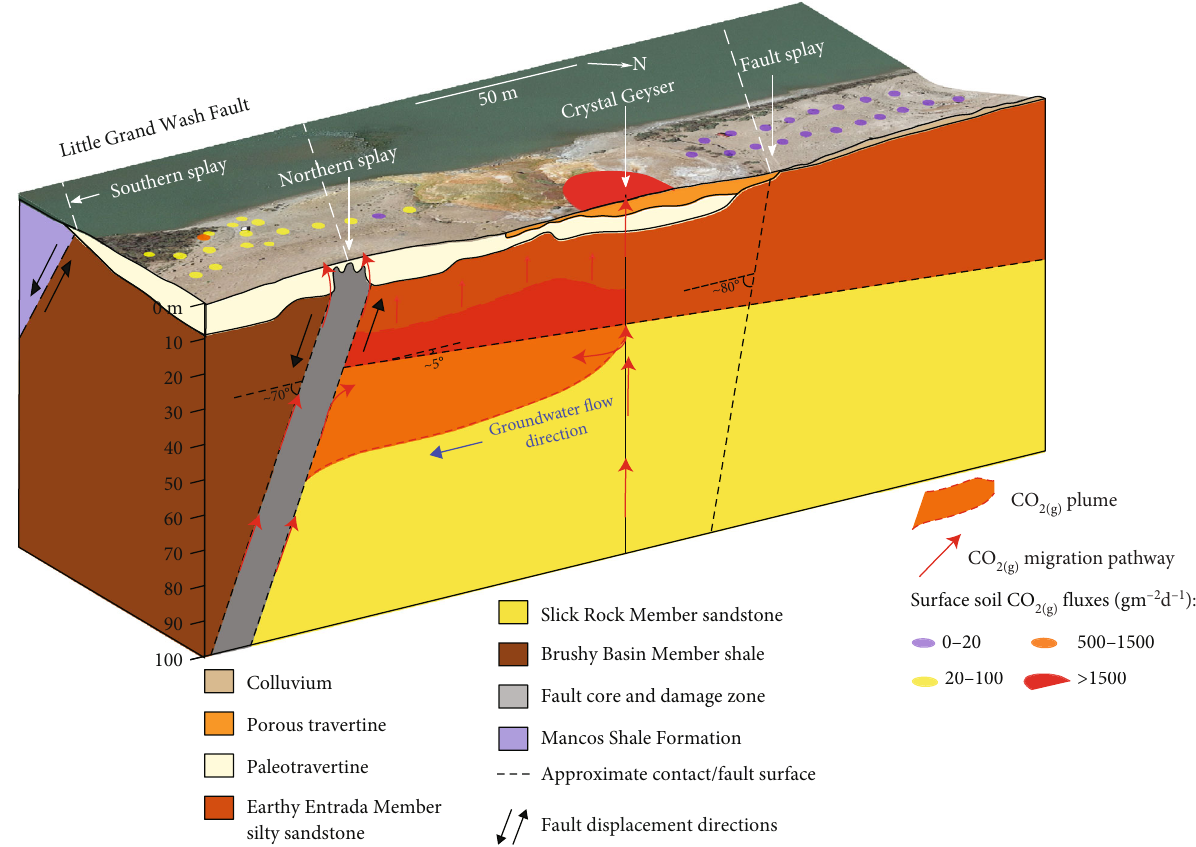
Figure 8: Conceptual model adapted from Figure 5(a) of interpreted subsurface geology with free-phase gas (FPG) distribution and fl ux measurements by Jung et al. [16] are overlain onto the surface. The damage zone of the Little Grand Wash migration. The CO 2(g) Fault (northern primary splay) and Crystal Geyser supply FPG to the gas trap beneath the Earthy Member silty sandstone (red arrows within the plume). The gas trap is bounded laterally by the fault and geyser conduit (N-S) and by the limbs of the Green River Anticline (W-E). The fault and Crystal Geyser are the predominant FPG pathways to the surface (red arrows leading to the ground surface). Between the Crystal Geyser and the fault, free gas migrates upwards up and around discrete capillary barriers within the Earthy Entrada Member (small red arrows above plume). Figure S7 is an alternate version of Figure 8 with the tomogram